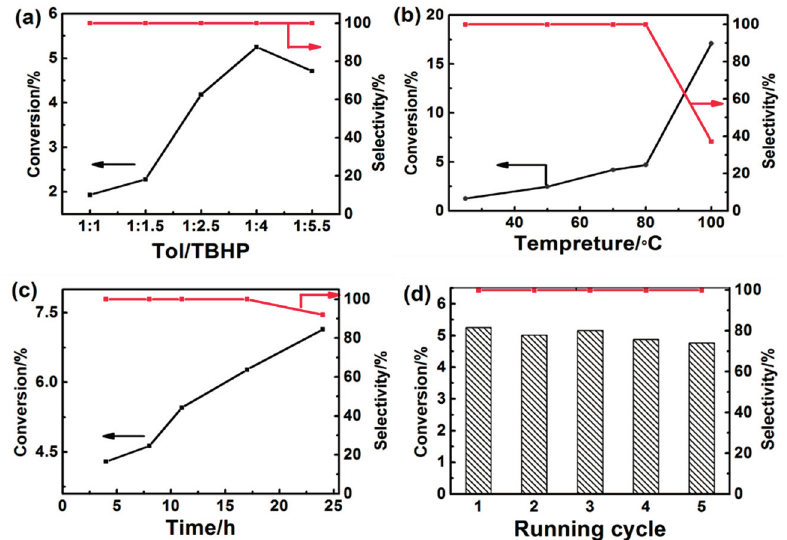
Figure 1. ( a ) The influence of the amount of TBHP on the selective oxidation of toluene over Cu-CNB (70 °C, 10 h); ( b ) The influence of reaction temperature on the selective oxidation of toluene over Cu-CNB (25 mmol of TBHP, 10 h); ( c ) The influence of reaction time on the selective oxidation of toluene over Cu-CNB (40 mmol of TBHP, 70 °C); ( d ) Reuse of the catalyst Cu-CNB for the selective oxidation of toluene (40 mmol of TBHP, 70 °C, 10 h). Reaction conditions: 30 mg of catalyst, 10 mmol of toluene, 3 mL of